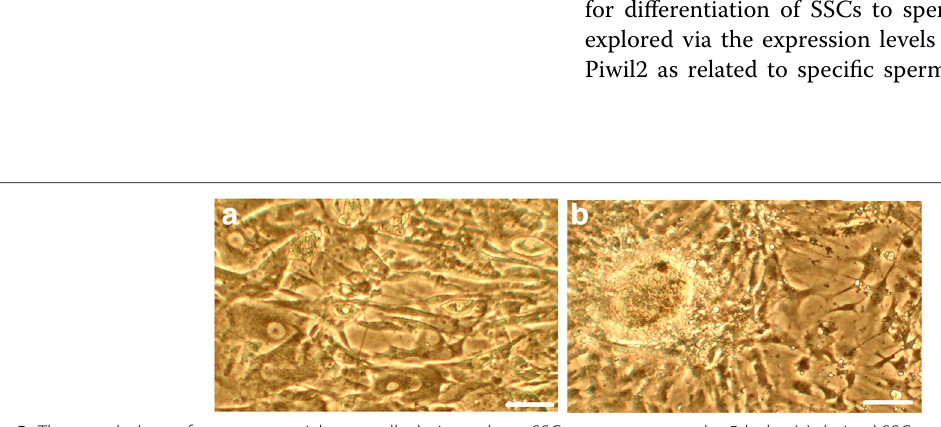
Fig. 3 The morphology of spermatogonial stem cells during culture. SSCs appearance on the 5th day (a) derived SSCs colonies’ 14th day of culture. Scale bars 100